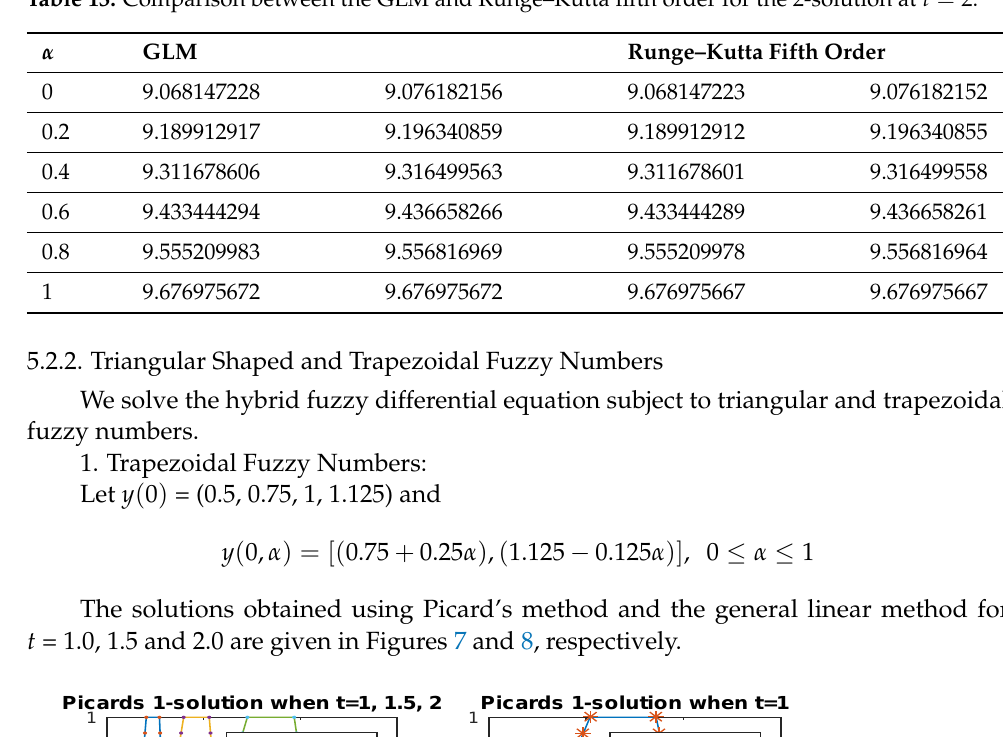
Table 13. Comparison between the GLM and Runge–Kutta fifth order for the 2-solution at t = 2.